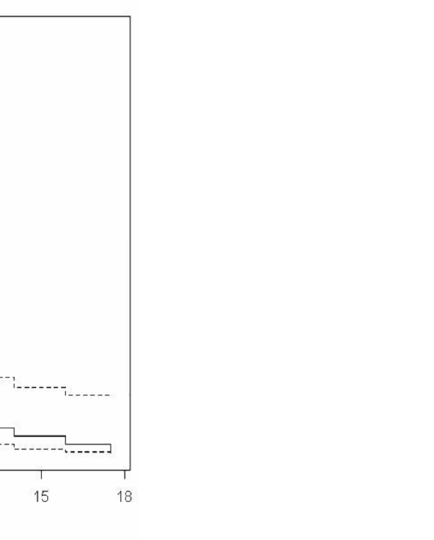
Fig 2. Kaplan-Meier curve of Resonance